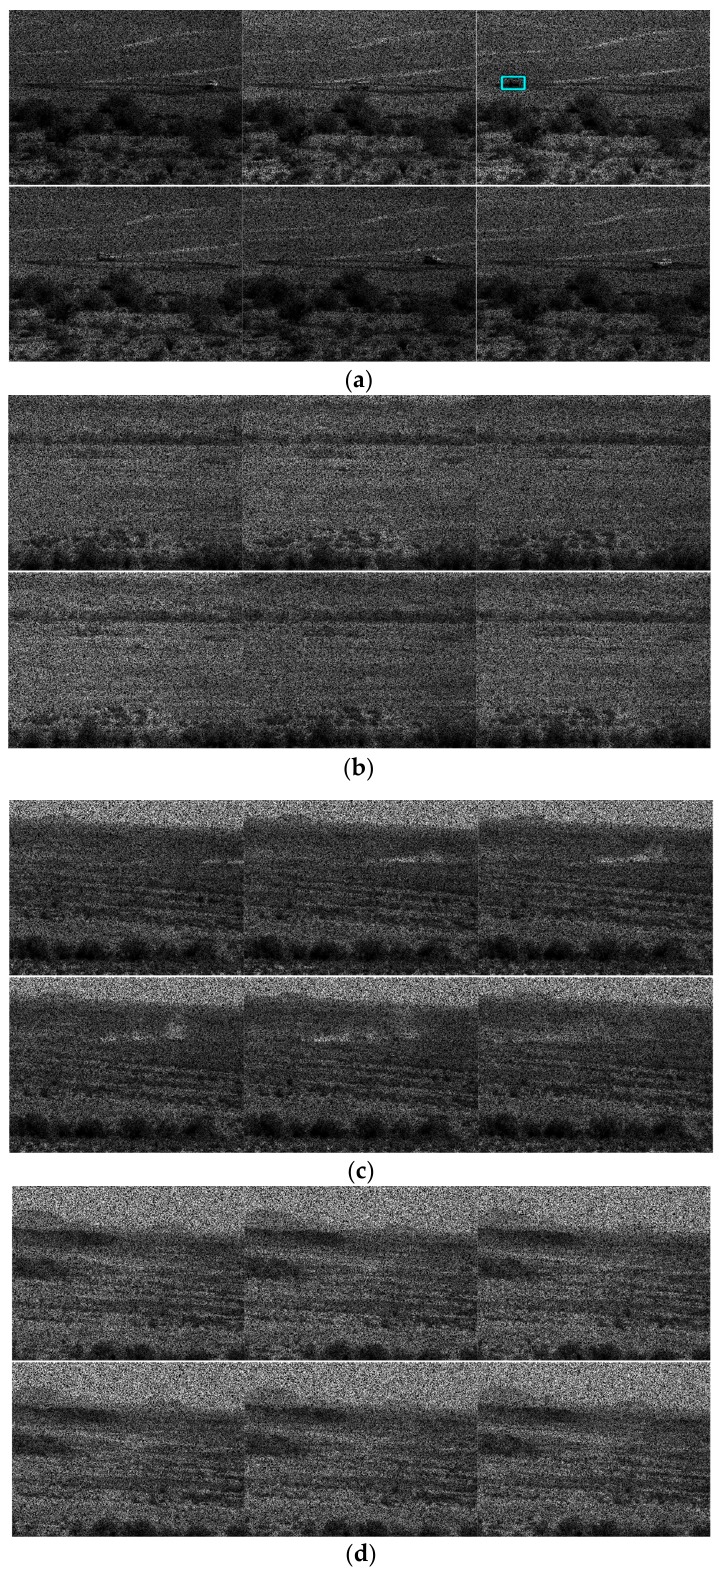
Figure A1. Tracking results for frames 1, 63, 126, 189, 252, and 315 for the PCE 50 (optical video) case. The vehicle is SUV. Most of the captured frames do not have detection. Dusts can be seen in some frames and have serious impacts on the tracking and classification performance. ( a ) 1000 m; ( b ) 2000 m; ( c ) 2500 m; and ( d ) 3500 m. Table A2. Tracking metrics for PCE 25 (optical video). ND means “no detection”. 1000 m